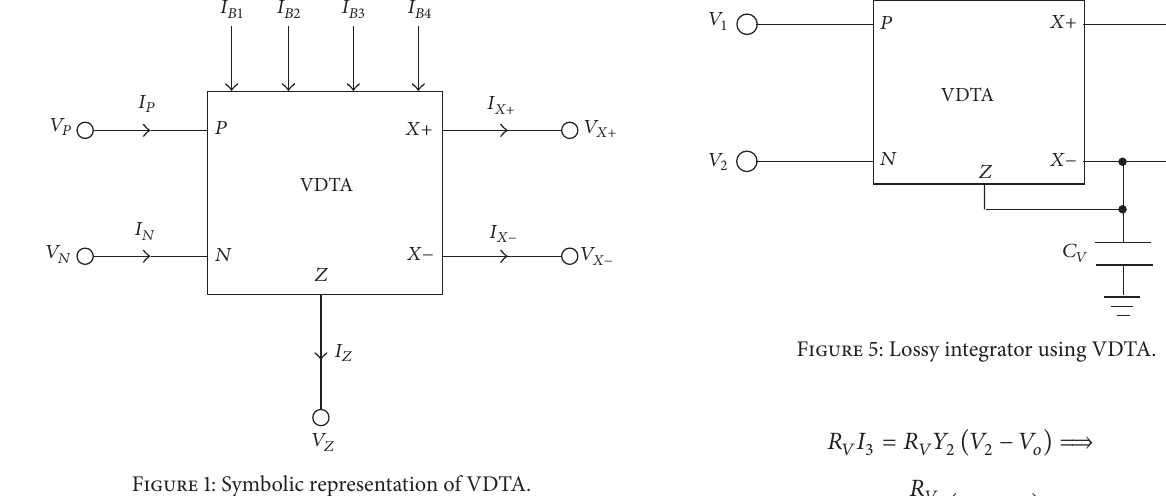
Figure 1: Symbolic representation of VDTA.